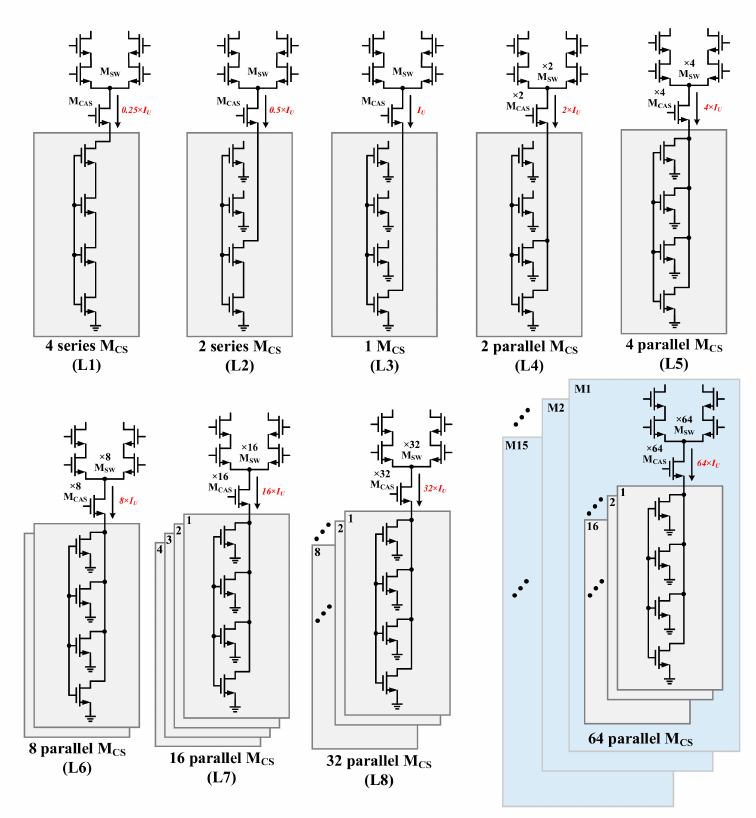
Figure 4. Switching current sources array design.